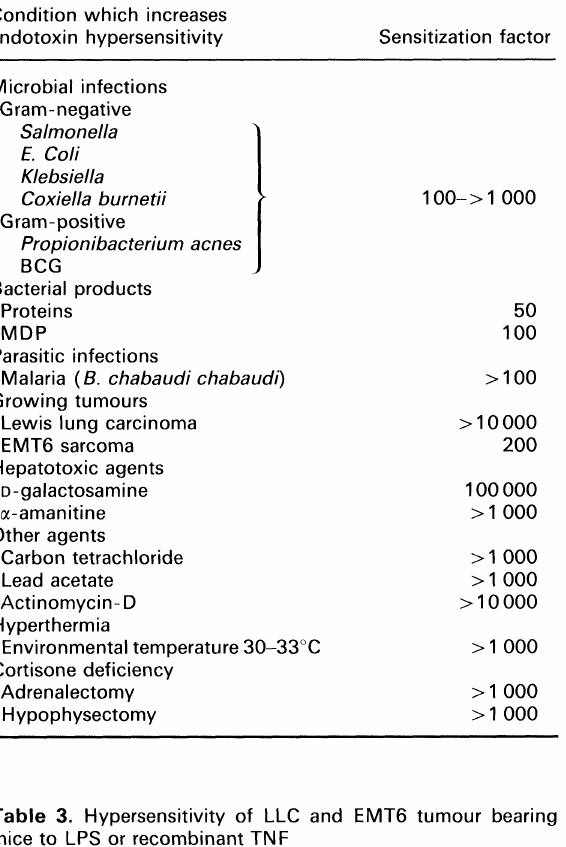
Table 2. Induction of hypersensitivity to endotoxin treatment